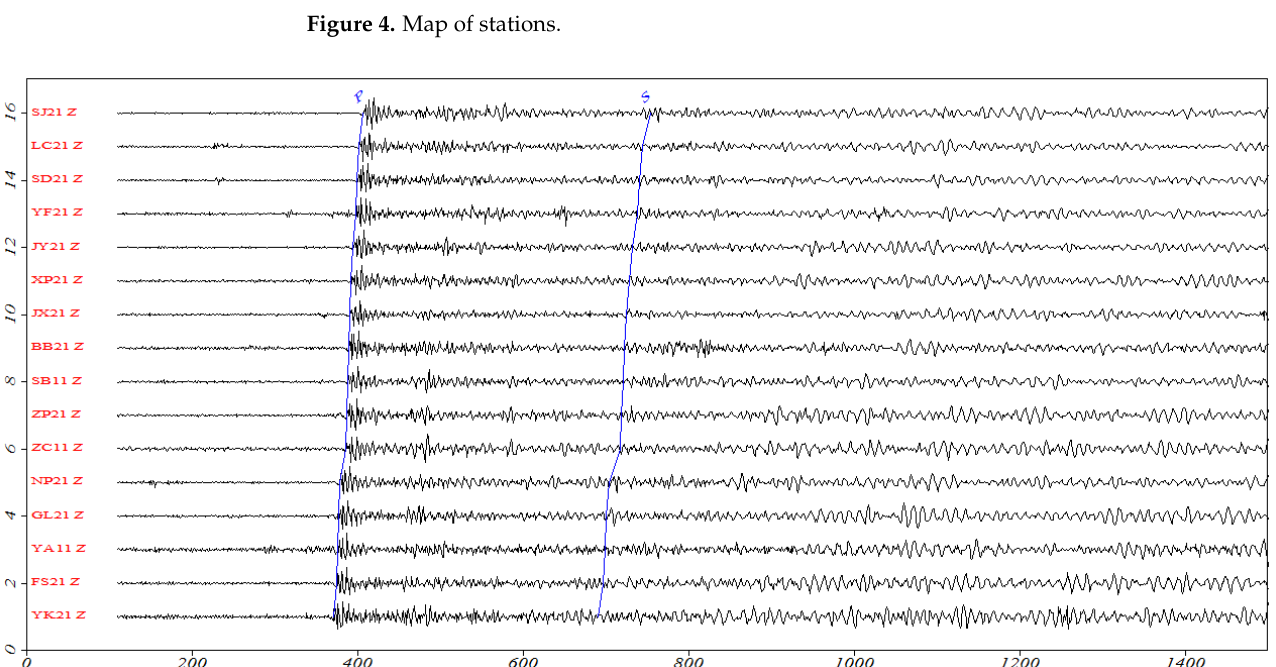
Figure 5. Theoretical arrival times of seismic records and P and S phases in the Alo Islands.